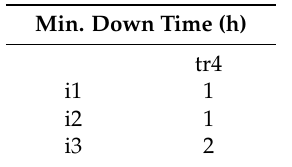
Table A11. Minimum time unit i has to be shut down (h): g_down( i ).